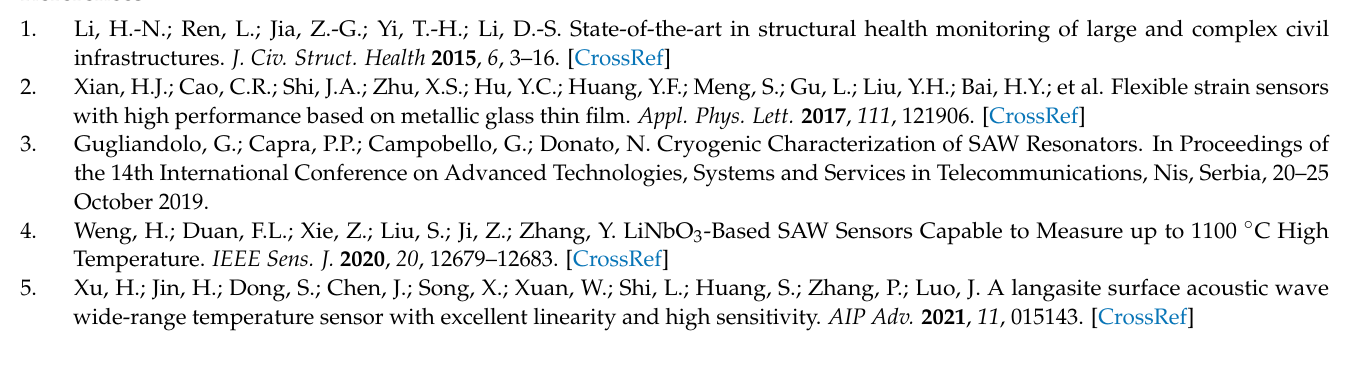
the size of the LN (mm 2 )